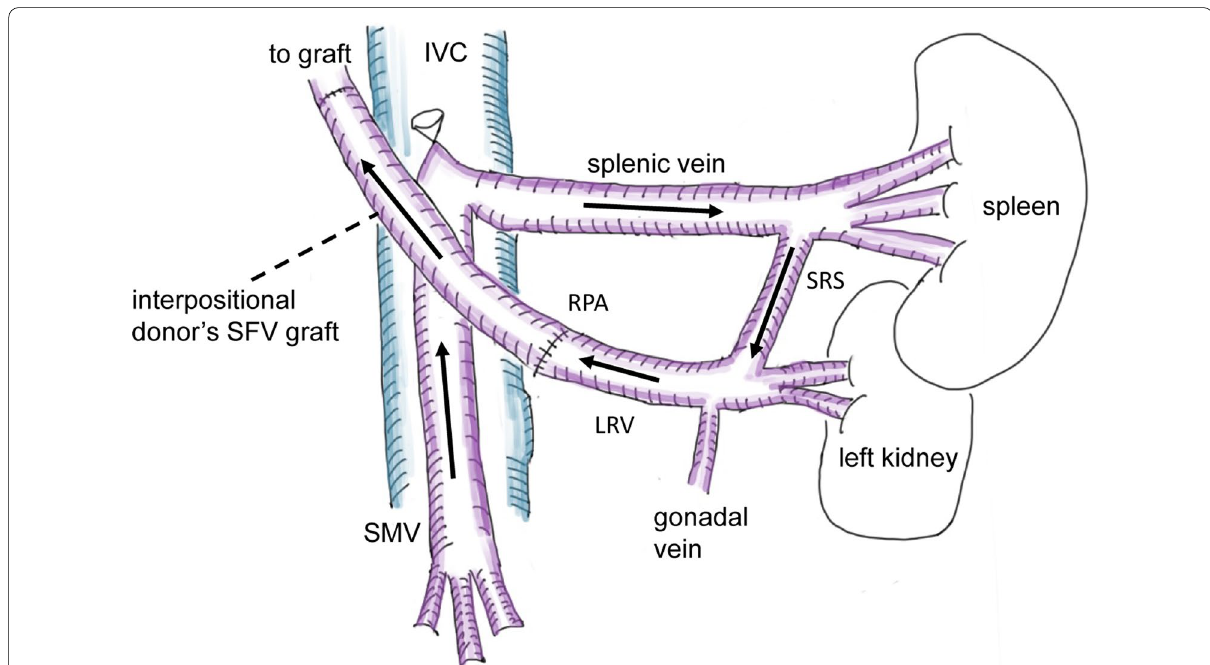
Fig. 1 Schematic figure of RPA. The black arrows indicate blood flow from SMV to the liver graft. IVC inferior vena cava, LRV left renal vein, RPA renoportal anastomosis, SFV superficial femoral vein, SMV supramesenteric vein, SRS splenorenal